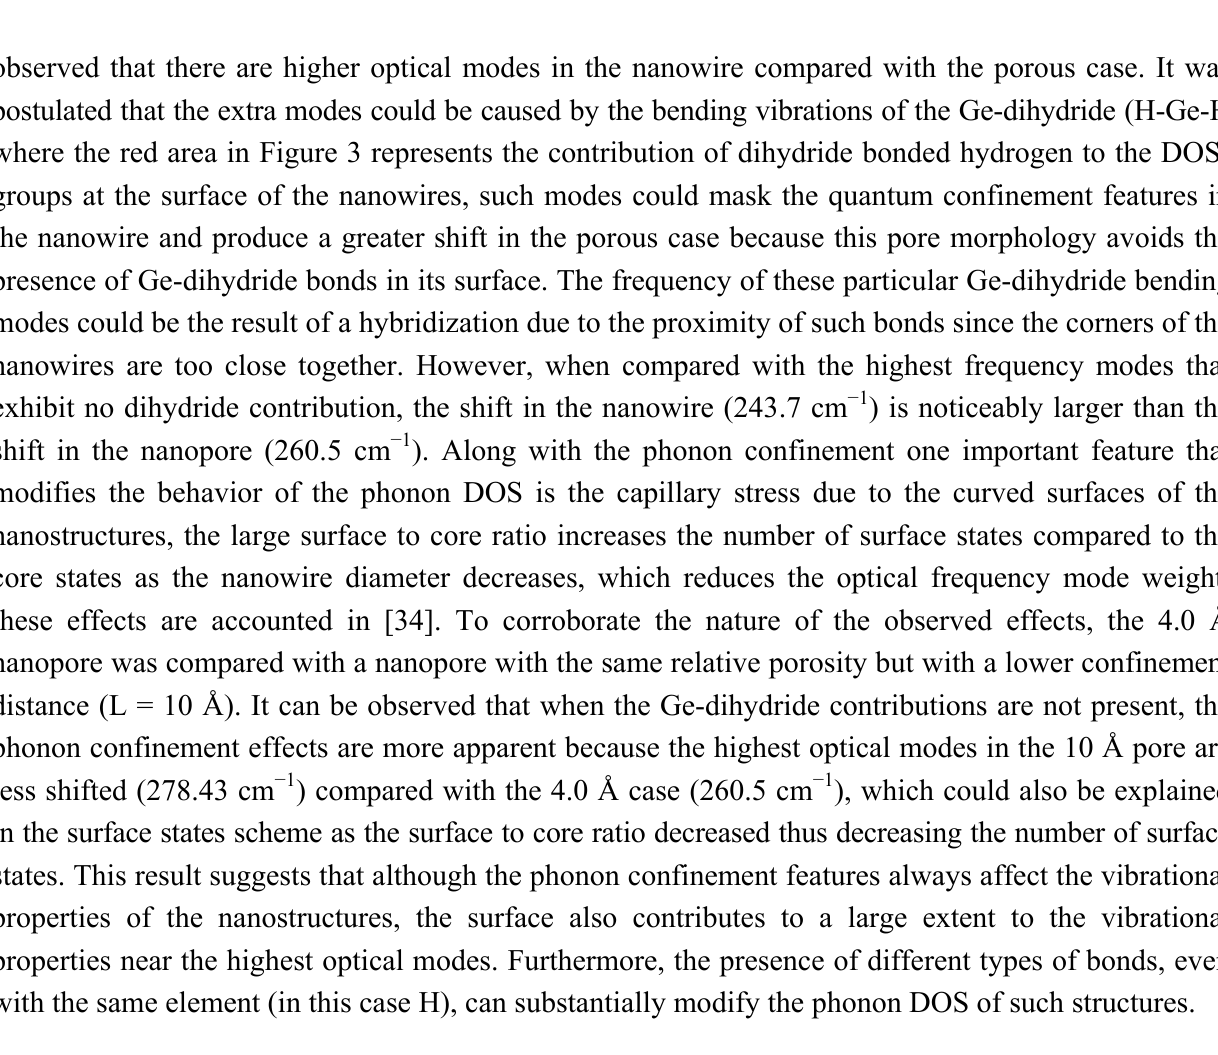
Figure 3. Partial phonon density of states (PDOS) of ( a ) GeNW with d = 4.0 Å, ( b ) pGe with L = 4.0 Å and p = 12.5%, and ( c ) pGe with L = 10.0 Å and p = 12.5%. The green, red and blue areas represent Ge, hydride and dihydride vibrations,